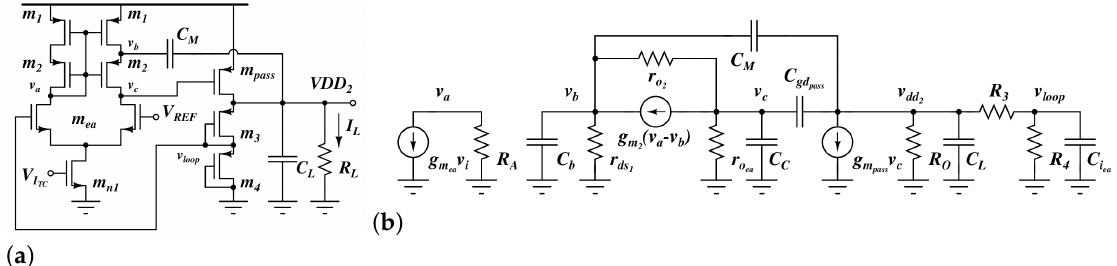
Figure 8. LDO voltage regulator. ( a ) Schematic circuit. ( b ) Open-loop small-model signal